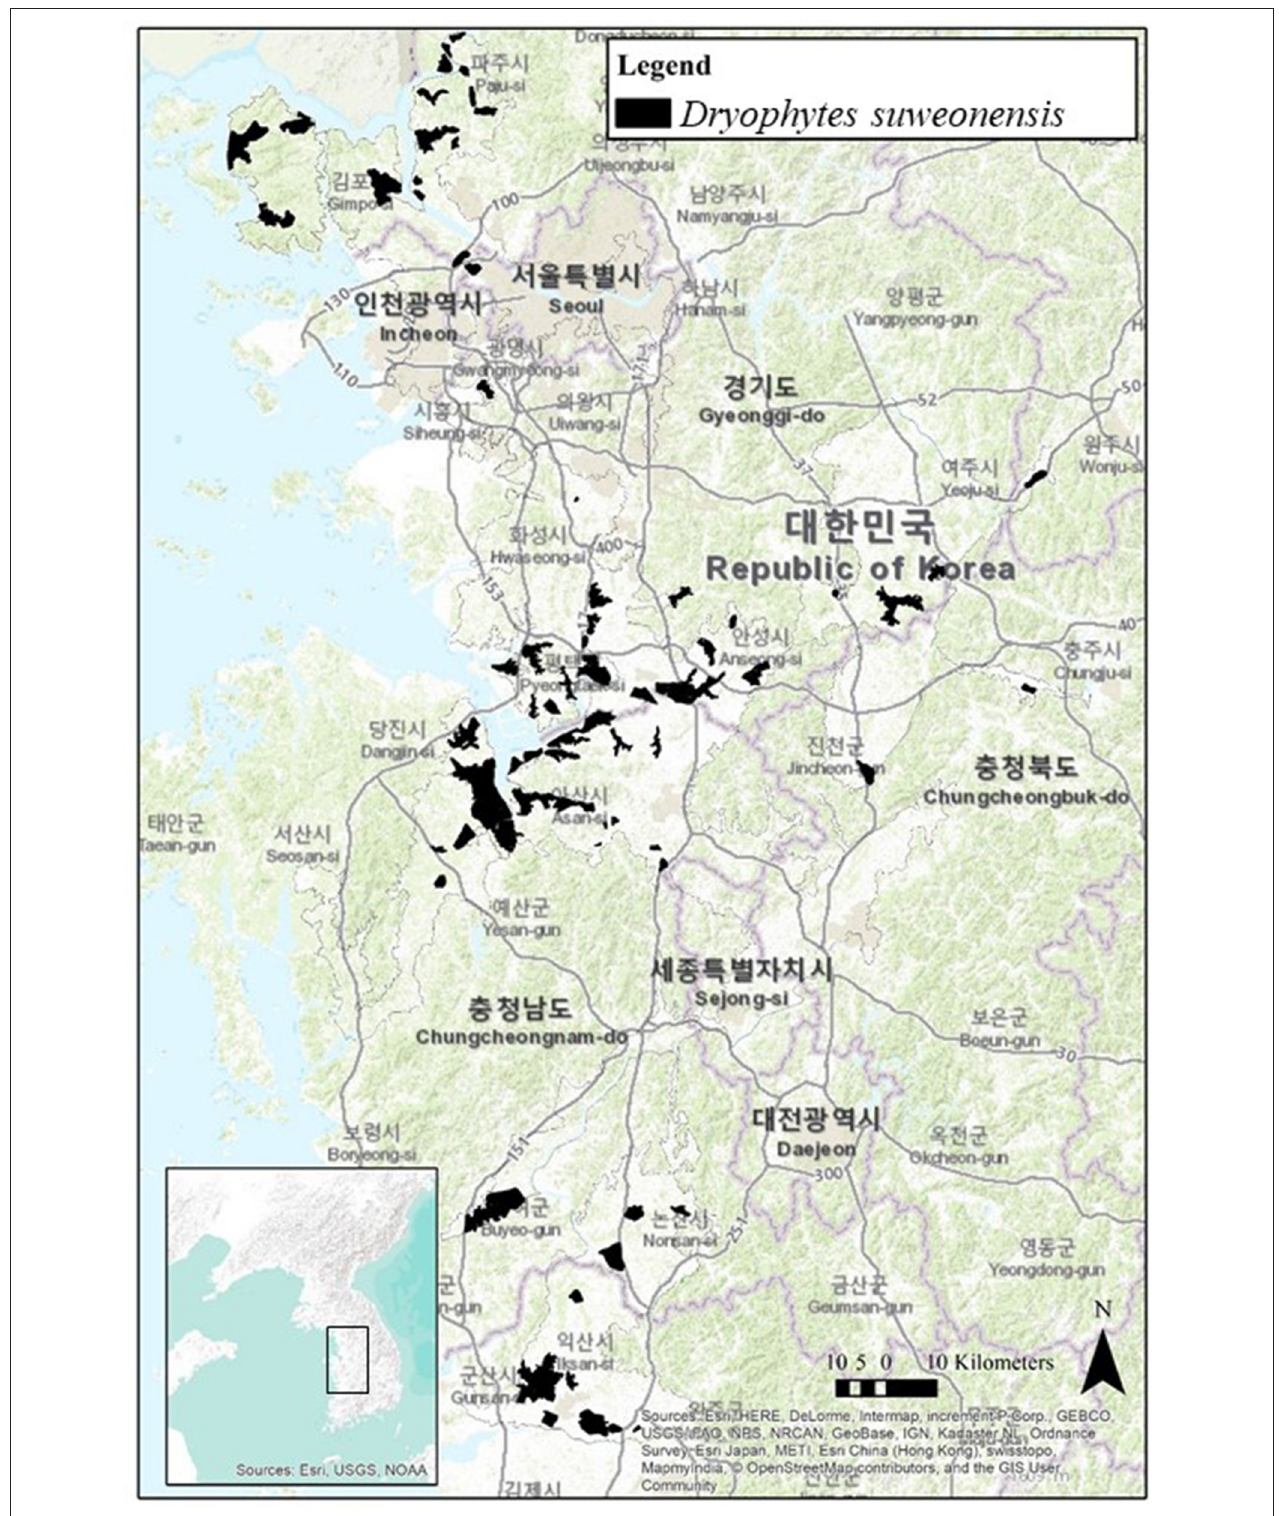
FIGURE 1 | Distribution of Dryophytes suweonensis in the Republic of Korea. Each black patch represents an area within which sites where the species is present are connected (Borzée et al., 2018a), but disconnected from the nearest rice-paddy complex (Borzée, 2018). The species range is extracted from Borzée et al. (2017a). Map generated through ArcMap 10.5 (Environmental Systems Resource Institute, Redlands, California, USA).